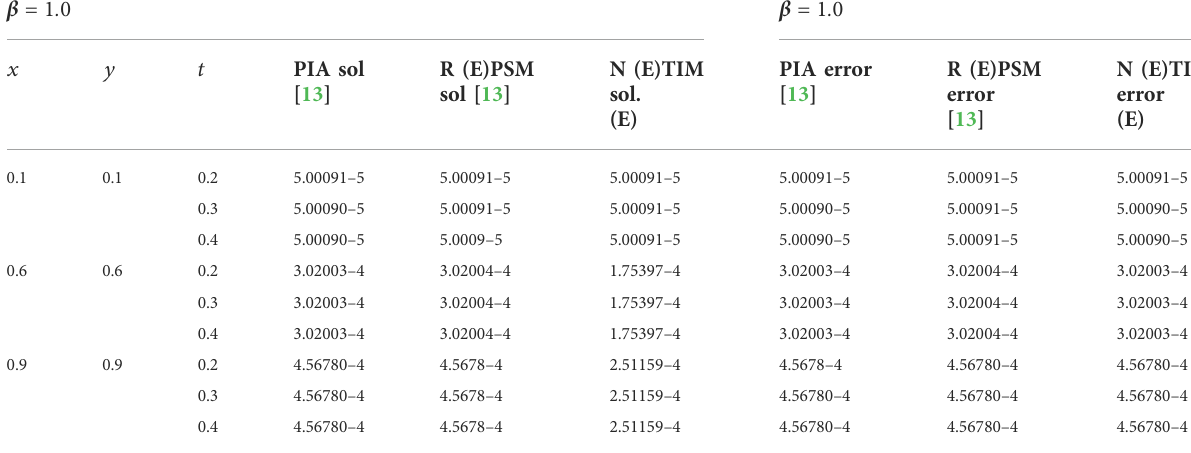
TABLE 4 Comparison of the second-order NTIM with the third-order RPSM and PIA method. β (cid:2) 1 . 0